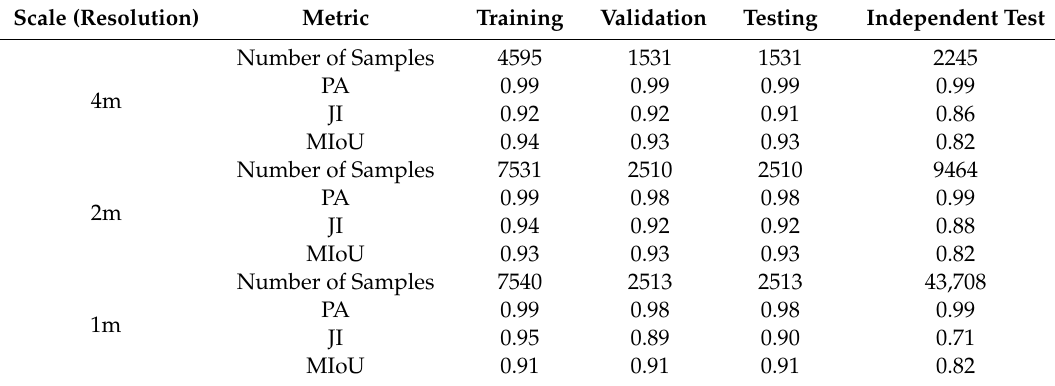
Table 1. Metrics of training, validation, testing, and independent test at three